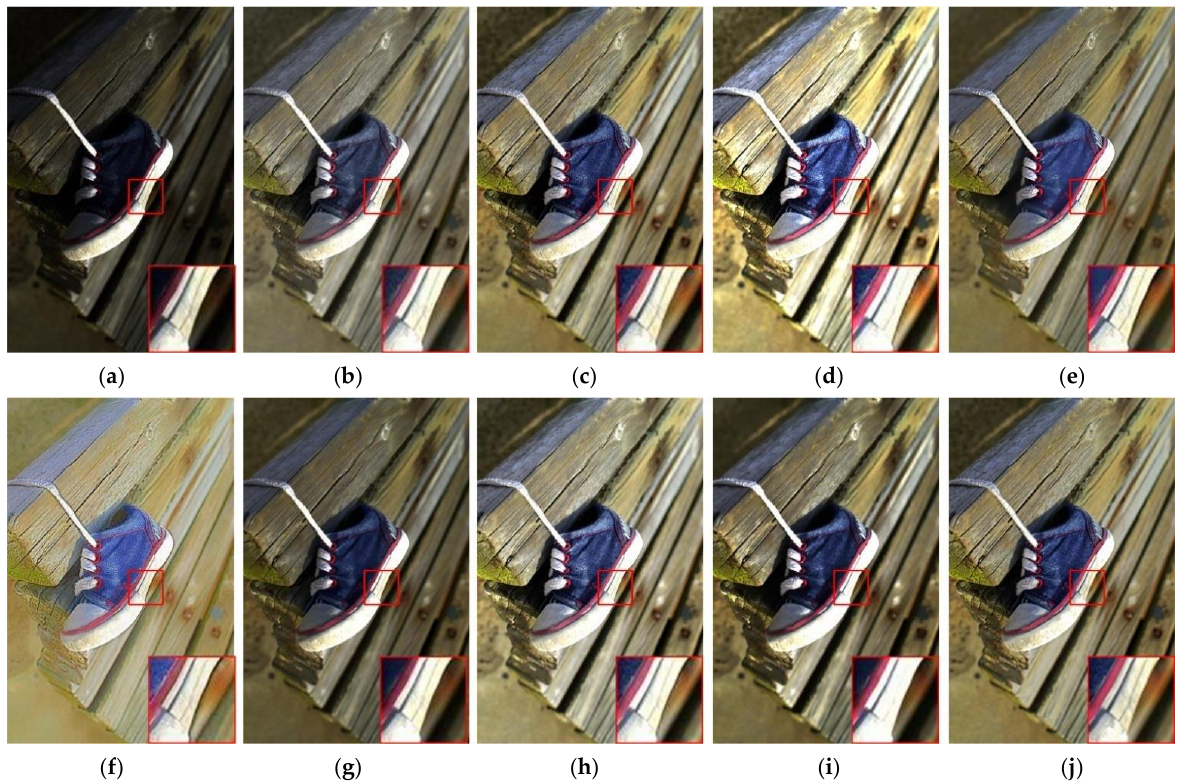
Figure 18. Enhanced results of “Shoes” image. ( a ) Original image; ( b ) BIMEF; ( c ) MEF; ( d ) LIME; ( e )